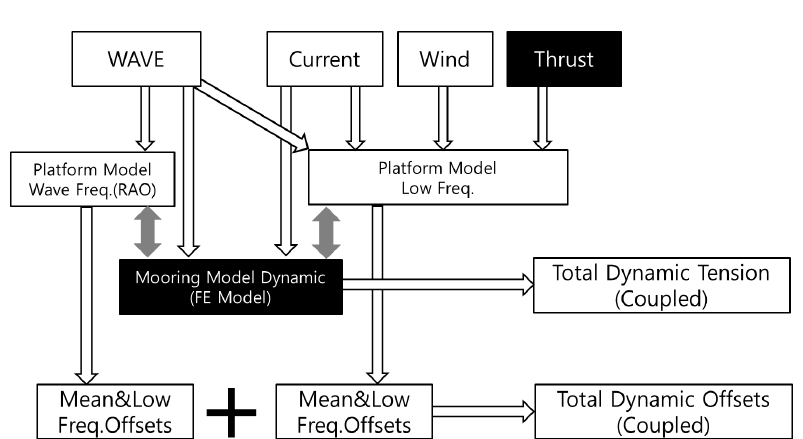
Figure 3. Uncoupled Analysis.